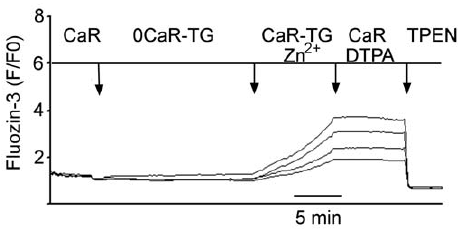
Figure 5. Ca 2 + -dependent increases in [Zn 2 + ] i are attributable to influx from extracellular sources. Recording from imaging of a single gland (4 individual parietal cells) loaded with fluozin-3. The recording begins with perfusion in standard Ca-Ringers solution, followed by 0 Ca Ringer’s containing 2 m M thapsigargin, which depletes intracellular calcium stores. During exposure to 10 m M Zn 2 + , in the presence of Ca 2 + , a monotonic increase in [Zn 2 + ] i follows, similar to that observed in Figure 4C . With addition of an excess of DTPA (100 m M), a high affinity and membrane impermeable chelator of heavy metals (but not Ca 2 + or Mg 2 + ), the accumulation of Zn 2 + is arrested. In 18 cells monitored in 5 glands, this arrest was always observed, demonstrating that Ca 2 + dependent loading of Zn 2 + was due solely to influx from extracellular